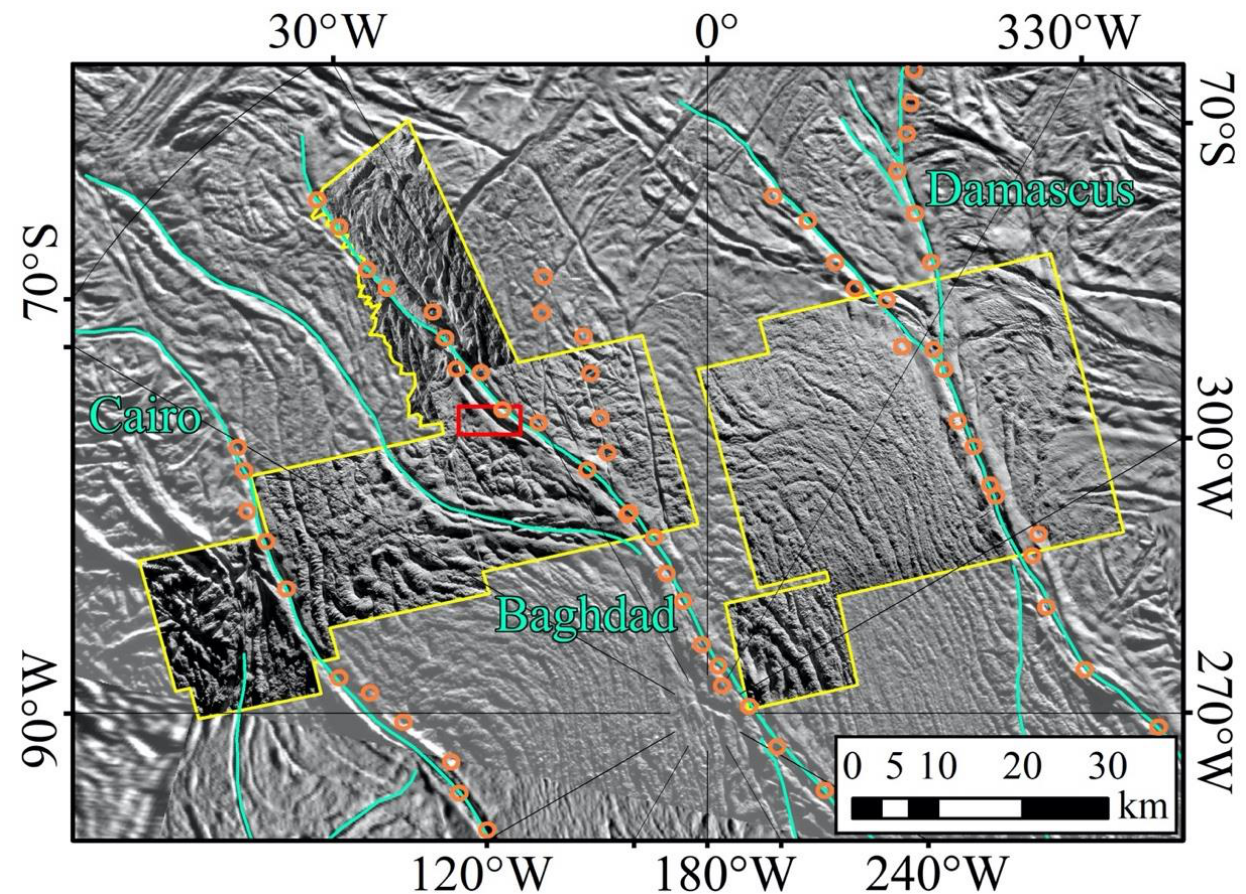
Figure 2. The eight projected ISS-NAC images covering the region of interest between Damascus, Baghdad and Cairo Sulci (highlighted in light blue, following Crow-Willard and Pappalardo [7]). The yellow outline shows the full area covered by the dataset. On the left side of the saw-tooth yellow boundary, a bad signal-to-noise part of the image has been eliminated. The red rectangle shows the location of Figure 3, while the orange circles show the jets’ sources identified by Porco et al. [10].